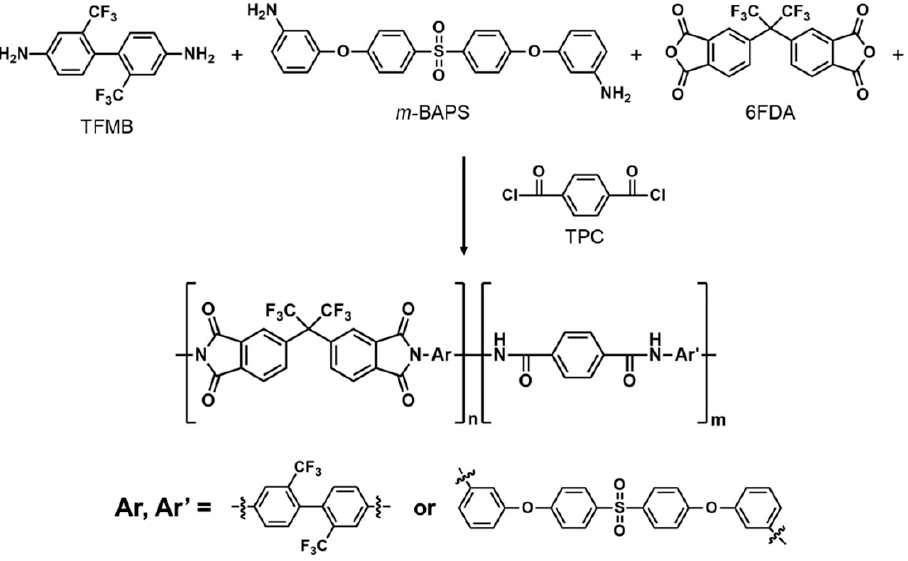
Scheme 1. Synthesis process of